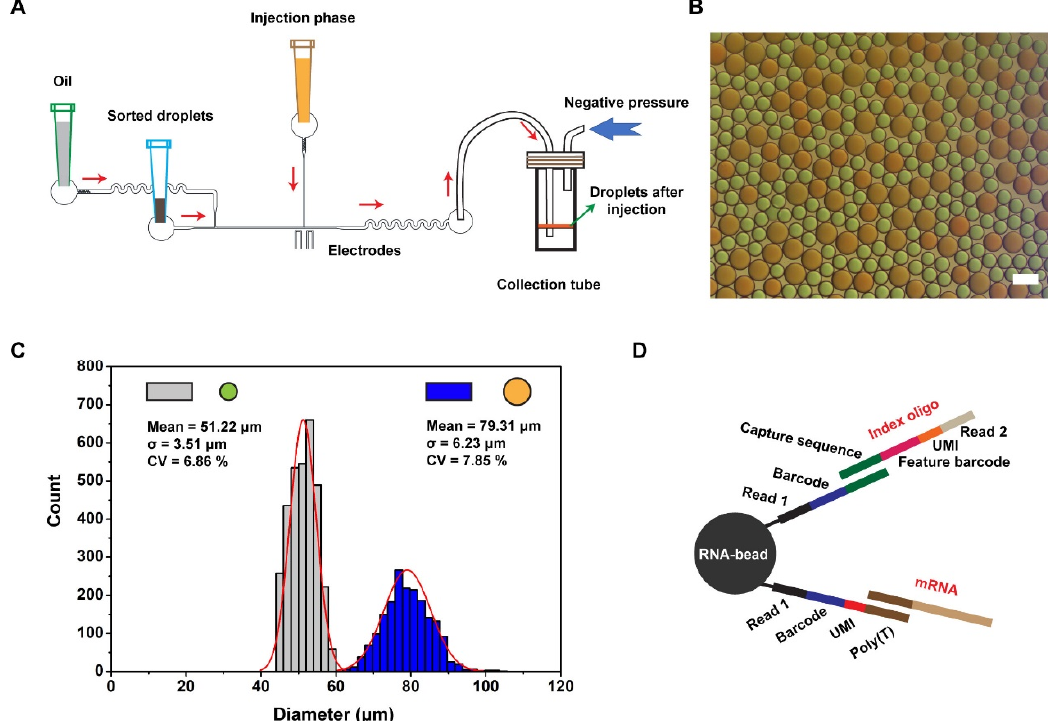
Figure 3. Droplet picoinjection and oligo design for RNA beads. ( A ) The schematic diagram of droplet picoinjection. Negative pressure drives oil, droplets, and injection reagent to flow through channels. Oil controls the distance between two adjacent droplets, and additional reagents are injected into droplets facilitated by an electric field. ( B ) The photograph of droplets after injection. To facilitate observation, droplets and injection were dyed with red and green, respectively, and then red droplets were orange, and leakage droplets of injection were green after injection. Scale bar is 100 μ m. ( C ) Diameter distribution of droplets (N = 3203, grey bar; N = 1870, blue bar). ( D ) RNA and index are captured by RNA beads with different capture handles. Sequence structure for capturing index: Bead, read1, barcode, and capture sequence. For capturing RNA: bead, read1, barcode, UMI, and poly(T).